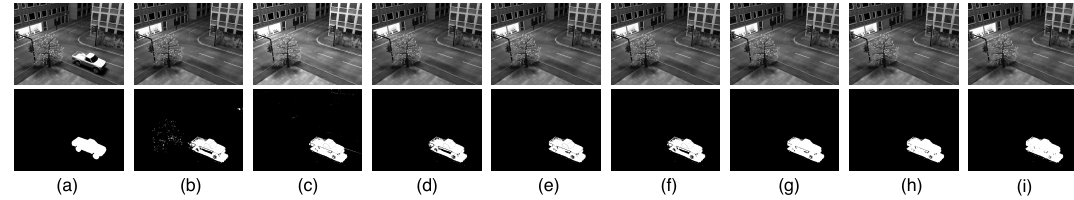
Figure 9. Background modeling results on the SABS data set. Each frame has a resolution of 600 × 800, and we stack the frames as the columns in our observed matrix Y ∈ R 480000 × 100 . ( a ) One frames of the original video Y (top) and the ground truth (bottom). Low-rank component X (top) and sparse component E (bottom) obtained by RPCA ( b ), LR-MDL ( c ), CoGEnT ( d ), BSGFL (e) PSSV ( f ), ROUTE ( g ), FGSR ( h ) and the proposed approach ( i ). Table 2. Quantitative evaluation of the background modeling, given as the F-measure and running time. Shopping Mall HumanBody2 MPEG F-Measure Times (s)